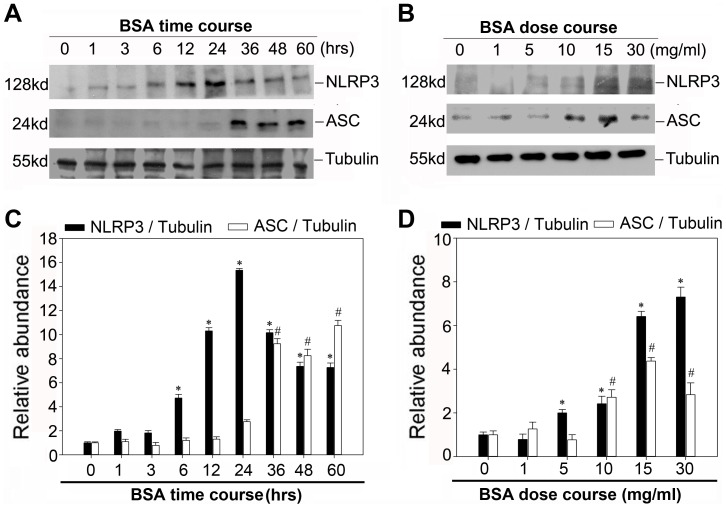
Bovine serum albumin induced NLRP3-inflammasome activation in NRK-52E cells.A. Western blot analysis showed the expression of NLRP3 and ASC proteins in NRK-52E cells after treatment without or with 5 mg/ml BSA for various time periods in serum-free medium. The whole cell lysate was immunoblotted with NLRP3 and ASC antibody, respectively. The same blot was reprobed with α-tubulin to confirm equal loading of each lane. B. Western blot analysis shows the expression of NLRP3 and ASC proteins in NRK-52E cells without or with different amounts of BSA for 12 h in serum-free medium. C and D: Graphical presentation shows the relative abundances of NLRP3 and ASC after normalization with α-tubulin. Data are presented as mean±SEM of three independent experiments. *P<0.05 vs. normal control (the relative abundance of NLRP3 protein level); # P<0.05 vs. normal control (the relative abundance of ASC protein level).